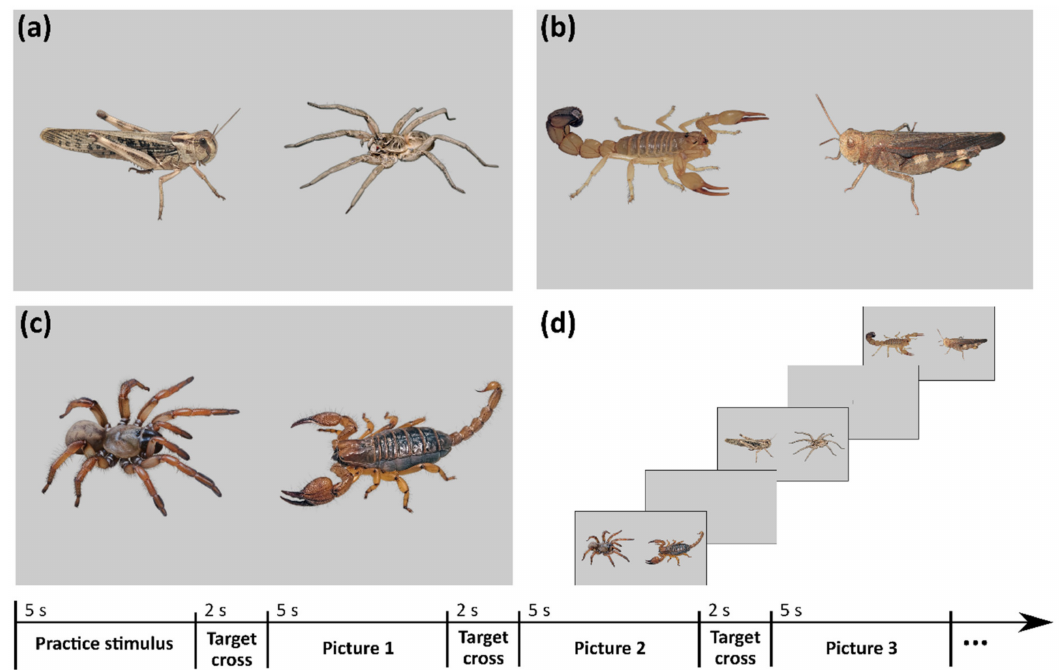
Figure 1. Examples of experimental stimuli, slide presentation, and timeline of the experiment. Pairs of stimuli were of three types: ( a ) spider–grasshopper, ( b ) scorpion–grasshopper, and ( c ) spider– scorpion. ( d ) During the experiment, pictures with stimuli were interlaced by 20% grey slides with a target cross in the middle. The axis shows a timeline of the experiment; altogether, there were 36 pictures with stimuli pairs. The species are as follows, from left to right: ( a ) migratory locust ( Locusta migratoria ), photo by Daniel Frynta, and a wolf spider Lycosa leuckarti , photo by Bidgee via Wikimedia Commons (CC BY-SA 3.0); ( b ) fattail scorpion ( Androctonus australis ), photo by Daniel Frynta, and sulphur-winged grasshopper ( Arphia sulphurea ), photo by Judy Gallagher via Flickr (CC BY 2.0); ( c ) North American mygalomorph spider of the genus Aptostichus , photo by Marshal Hedin via Flickr (CC BY-SA 2.0), and the scorpion Pandinurus phillipsii , photo by Daniel